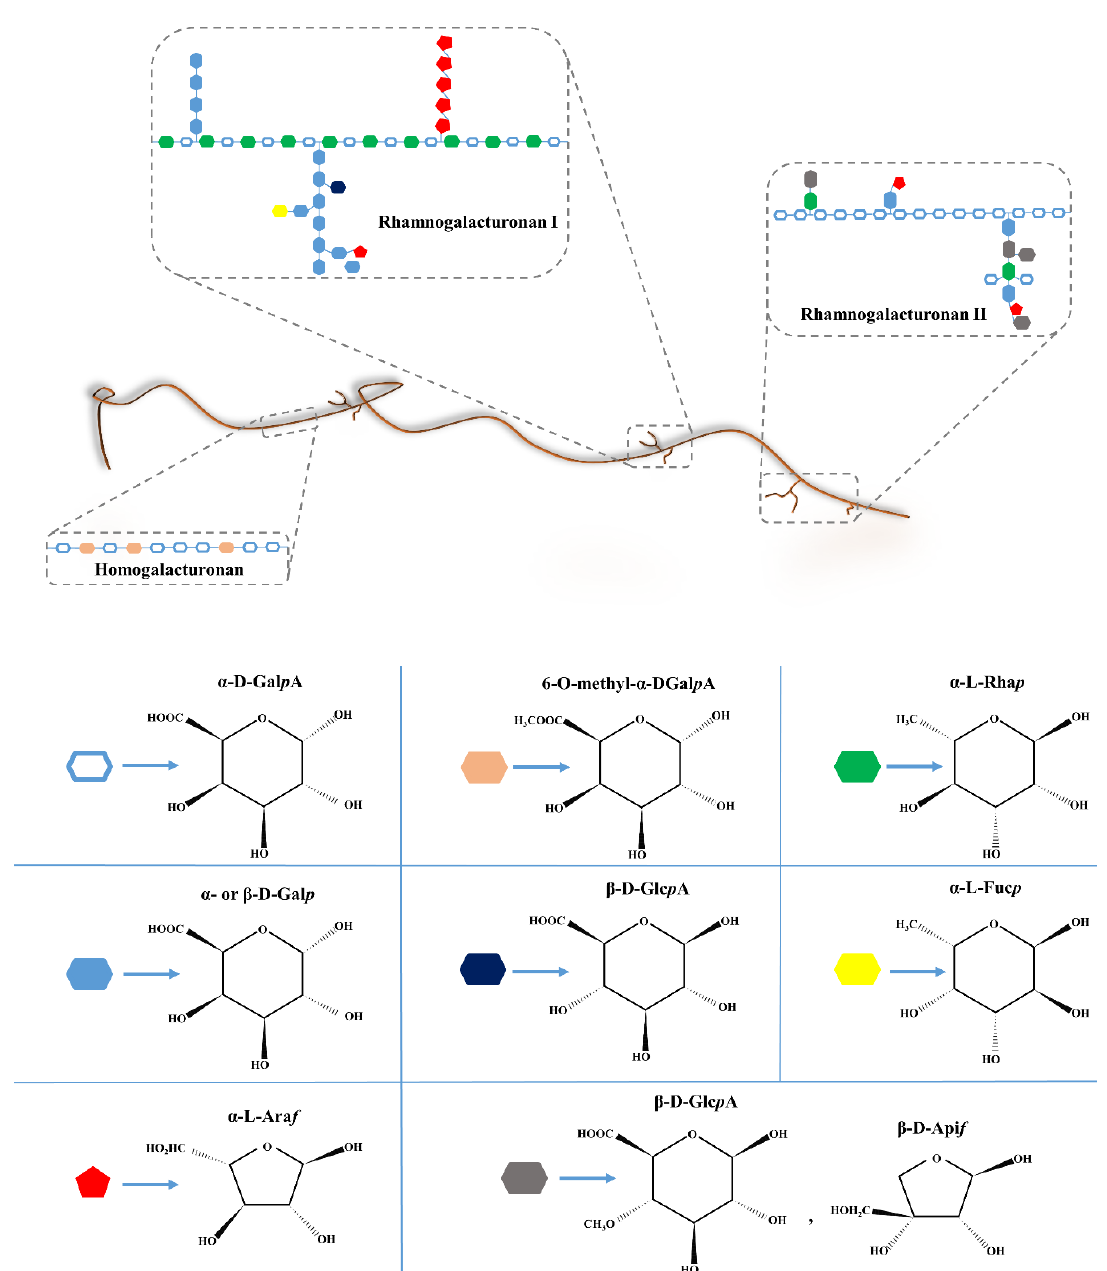
Figure 5. Schematic representation of the pectin structure with the main domains and monosaccharide composition, adapted from References [78,183 – 185].